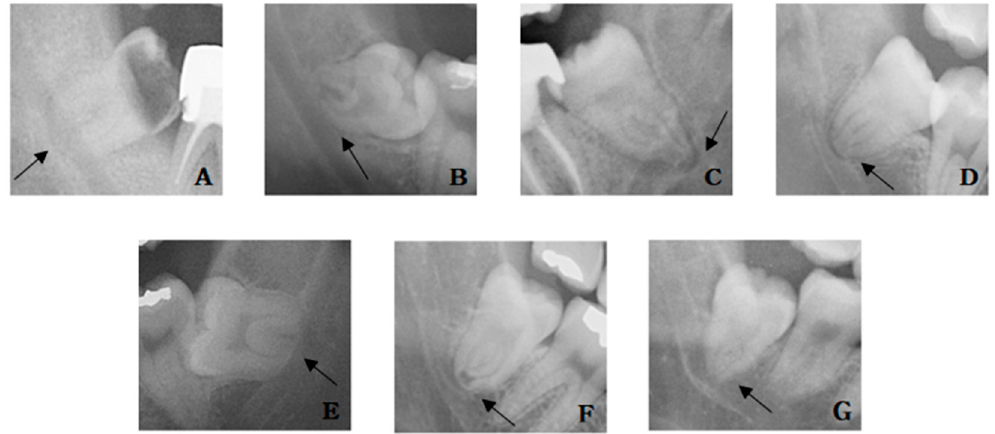
( D ) dark line in apex, ( E ) loss of white line, ( F ) inferior alveolar nerve (IAN) narrowing, and ( G ) IAN diversion.